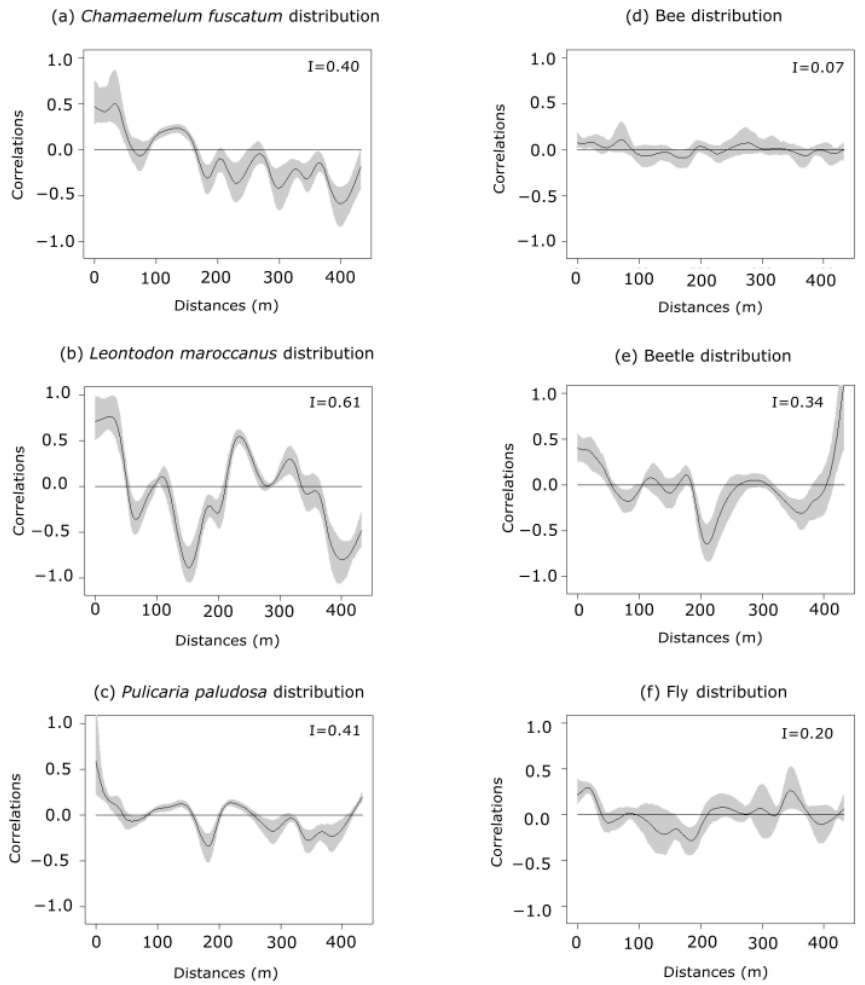
Figure 1. Spatial autocorrelation of plant abundances of the three plant species (panels a , b and c : C. fuscatum , L. maroccanus and P. paludosa , respectively) and of the three main pollinators (panels d , e and f : bees, beetles and flies, respectively) at increasing distances. The black line is the spatial correlation value that a species has for each distance; the gray shadow indicates the 95% confidence interval. The distribution of plant species individuals is more heterogeneous than the pollinator distribution. Within each panel, Moran’s I value is shown.